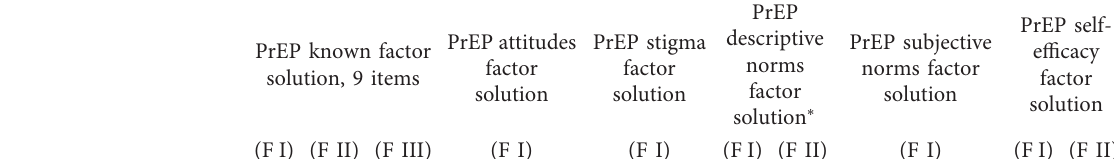
Table 3: Factor loadings for item scale versions (pattern